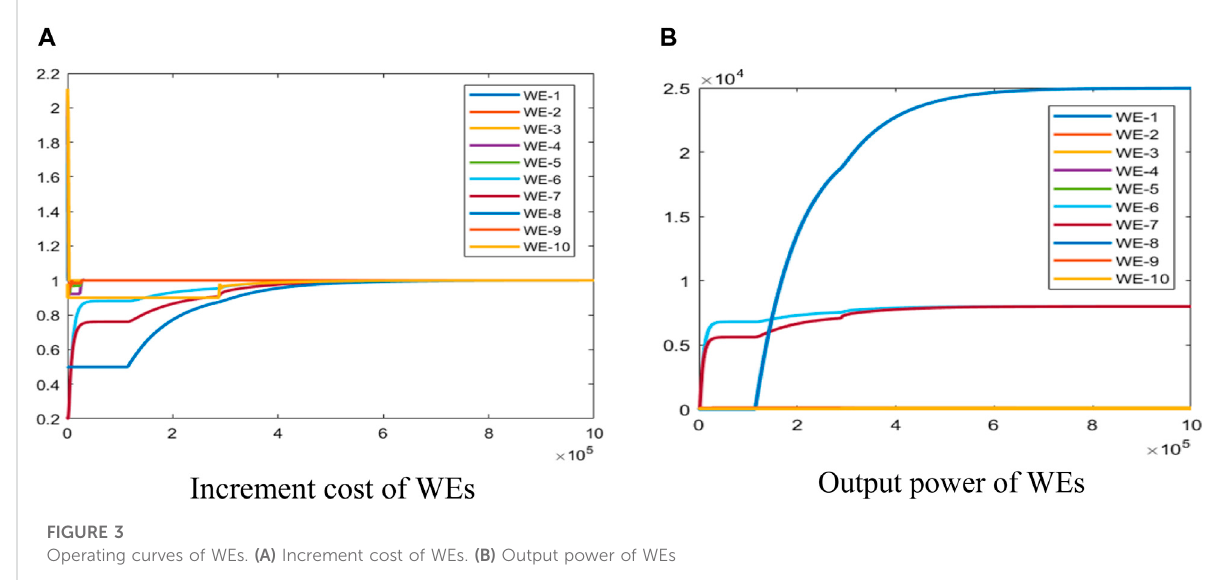
FIGURE 3 Operating curves of WEs. (A) Increment cost of WEs. (B) Output power of WEs